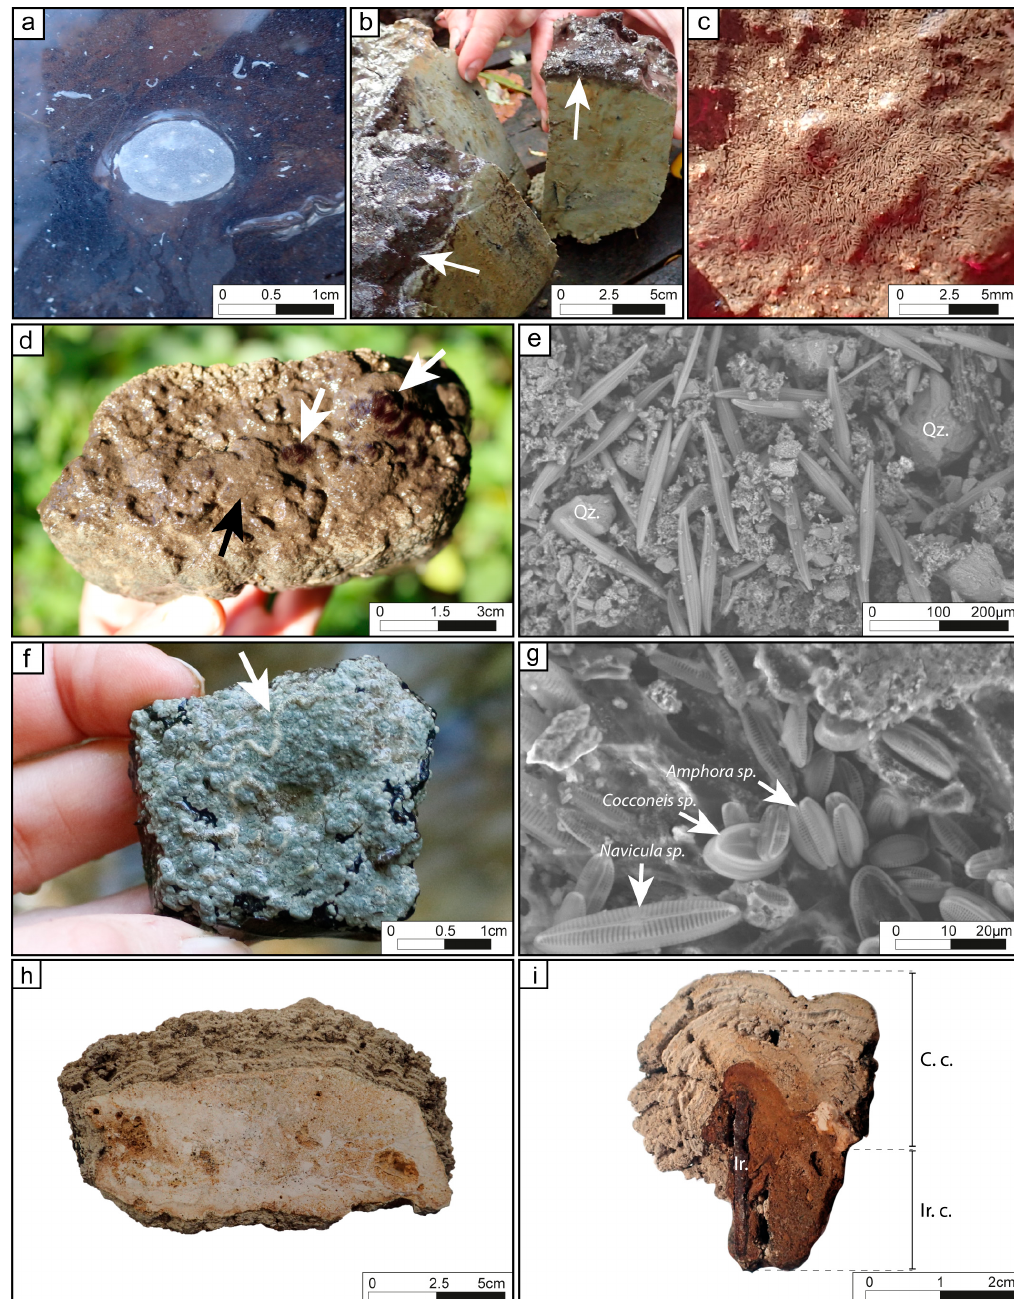
Figure 3. Organosedimentary structures observed in the stream. ( a ) White biofilms trapping a bubble at the water–air interface; ( b ) dark gelatinous slime (white arrows) overlying a muddy bottom sediment; ( c ) filament-rich clusters in cavities and on edges of gravels; ( d ) brown filaments (white arrows) and EPS-rich mats (black arrow) covering tufa microbialite; ( e ) SEM top view of brown filaments and diatoms of genus Gyrosigma (with copious amounts of EPS), and quartz grains (Qz) embedded in exopolymeric substance (EPS); ( f ) blue–green biofilms with larval housings (white arrow) forming meandering pattern covering tufa microbialite; ( g ) SEM view of blue–green biofilms covered by three genera of diatoms (Navicula, Cocconeis, Amphora); ( h ) cross-section of tufa microbialite on siliceous substrate showing alternation of mm-thick laminae ; ( i ) cross-section of tufa microbialite on ferrous substrate (Ir.) covered by an iron crusts (ir. c.) and a carbonated crust (C. c.) composed of alternations of laminae.